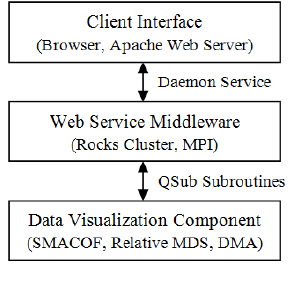
Figure 2. The web service Figure 3. The Web Service Middleware architecture.